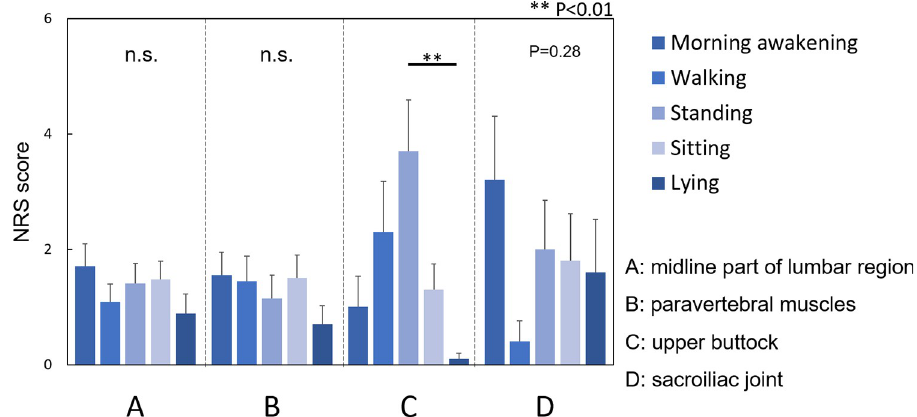
Fig 4. Relationship between the intensity of low back pain in different situations/positions and the location of low back pain. The differences in NRS scores of the LBP-one location group were evaluated in different situations/ positions. 1. Morning awakening, 2. Walking, 3. Standing, 4. Sitting, and 5. Lying down. A. midline of the lumbar region, B. paravertebral muscles, C. upper buttock, and D. sacroiliac joint. NRS: Numerical rating scale; LBP: Low back